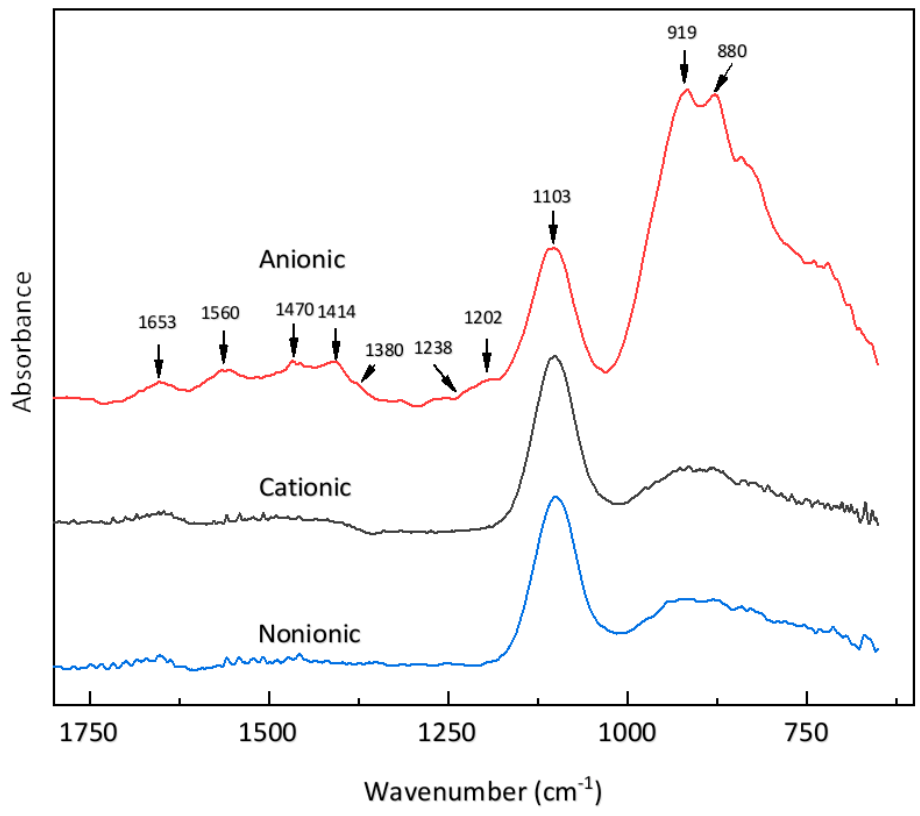
Figure 9. ATR-FTIR difference spectra of surfactants after 5 min of adsorption to cement